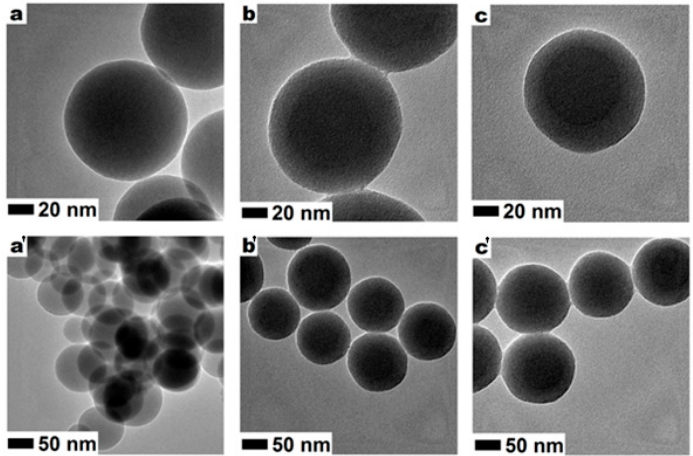
Figure 8. TEM images of the silica nanospheres in different magnifications before ( a,a’ ) and after incubation in the glucose solution ( b,b’ ) and PBS ( c,c’ ). incubation in the glucose solution ( b , b’ ) and PBS ( c , c’